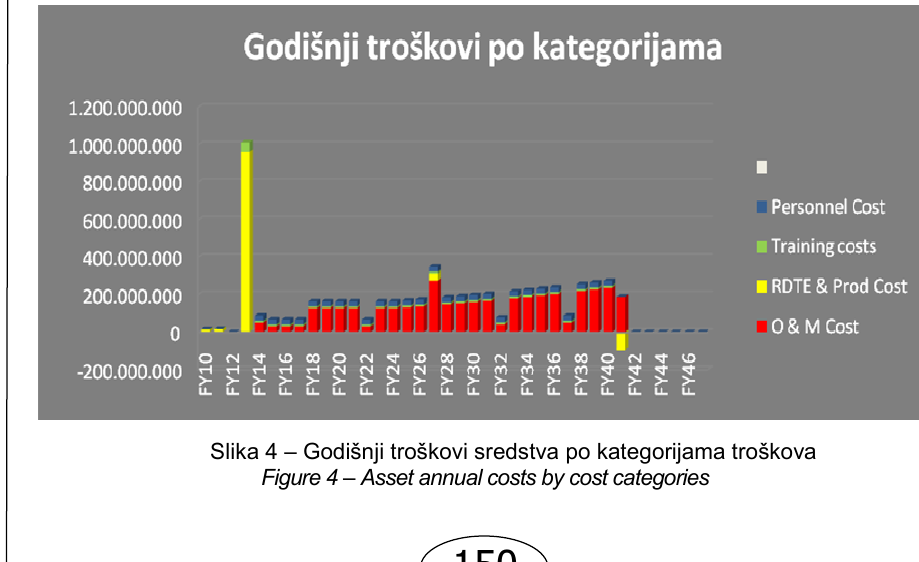
Figure 4 – Asset annual costs by cost